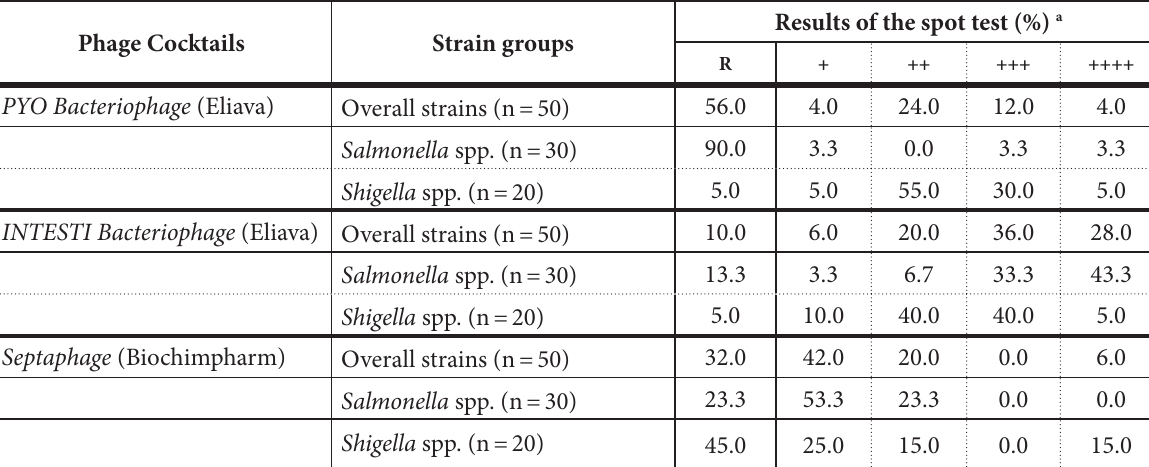
Results of the spot test (%) a